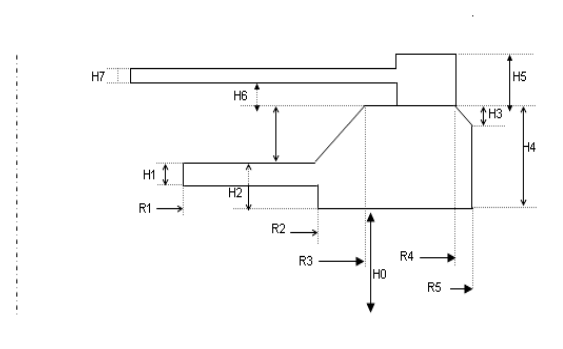
Fig. 4. Finite elements modelization of stator and rotor